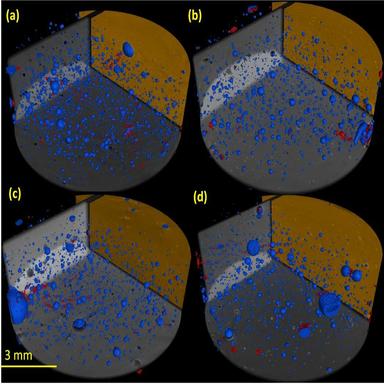
Size distributions of entrapped mercury drops and unfilled pores (sub panels) for (a) P03-15, (b) P03-30, (c) P03-60 and (d) P03-30SC samples.